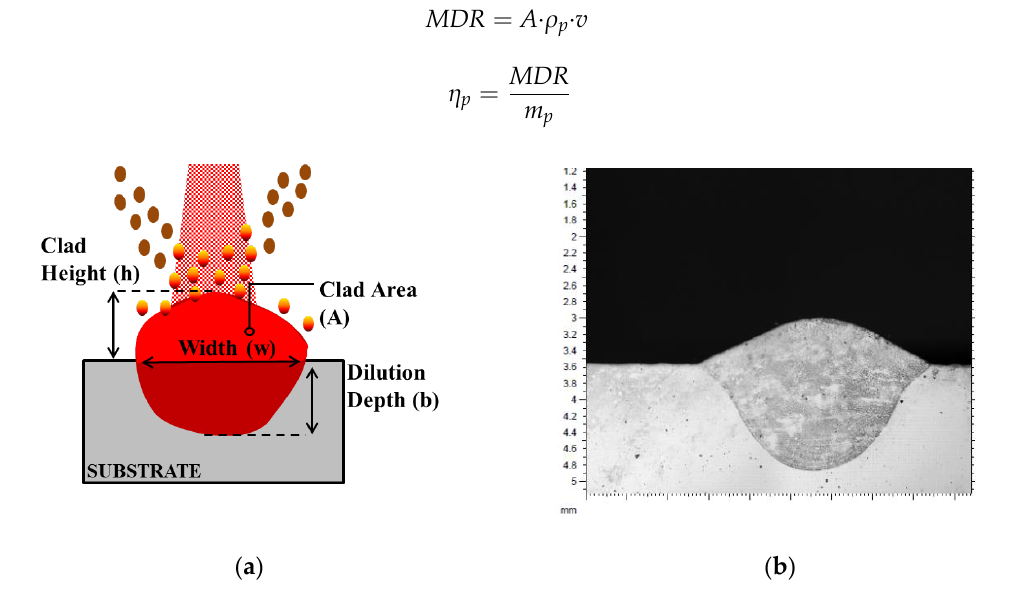
Figure 2. ( a ) Characteristics of a single clad; ( b ) macrophotography of a cross-section.